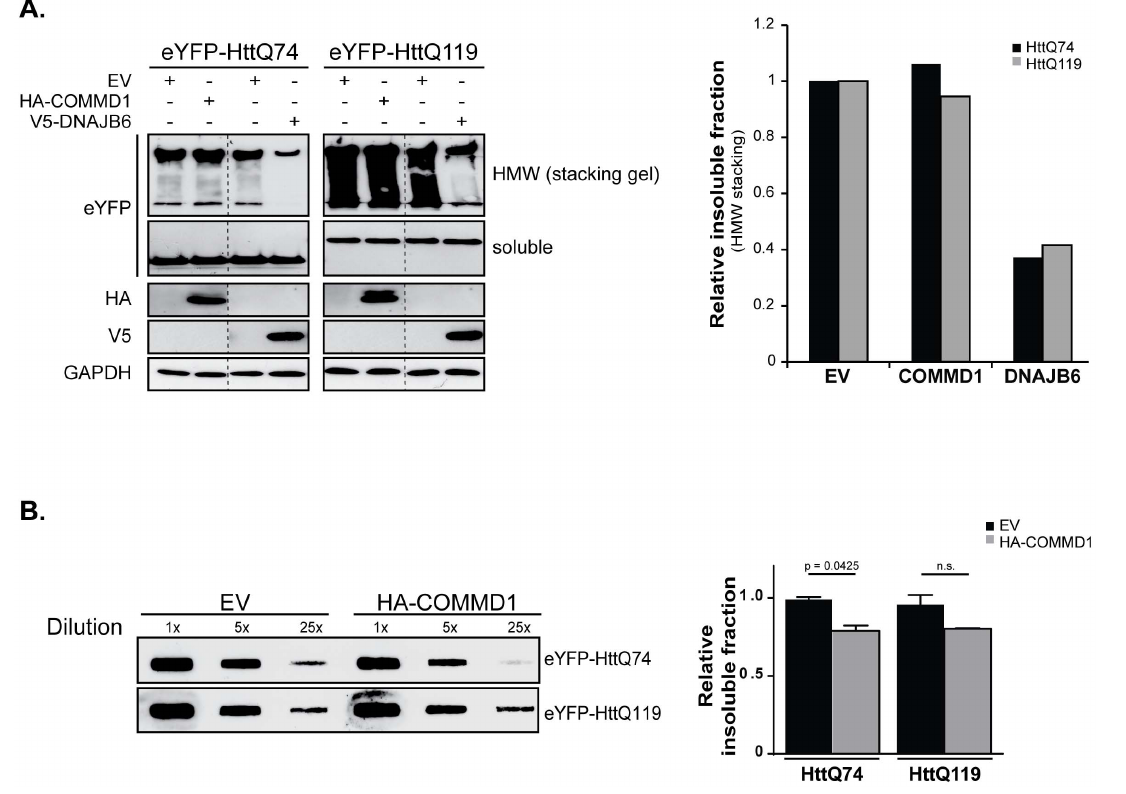
Figure 7. Aggregation of polyglutamine proteins is unaffected by COMMD1. A. HEK293T cells were transfected with eYFP-HttQ74 and eYFP-HttQ119 alone, or in co-expression with HA-COMMD1 or V5-DNAJB6 prior to lysis and detection of polyQ HMW complexes using SDS-PAGE. HMW aggregating complexes were trapped and detected in the stacking gel. IB was performed using indicated antibodies. Samples were analysed on the same membranes. Graph represents the relative fraction of insoluble HttQ74 and Q119 HMW species under EV conditions or upon co- expression of COMMD1 or DNAJB6. Insoluble Htt HMW species present in EV conditions were set at 1. B. Filter trap analysis of HEK293T cells transfected with the polyQ proteins eYFP-HttQ74 and eYFP-HttQ119, in co-expression with EV or HA-COMMD1. Samples were prepared as described under Experimental procedures and diluted as indicated. Immunoblotting was performed antibodies directed against the eYFP-tag. Densitometric quantification of insoluble fraction of HttQ74 and HttQ119, in absence or presence of exogenous COMMD1 (5x dilution). EV conditions were set at 1. p = 0.0425, indicates a significant decrease in insoluble HttQ74 aggregates mediated by COMMD1. n.s. = non-significant.